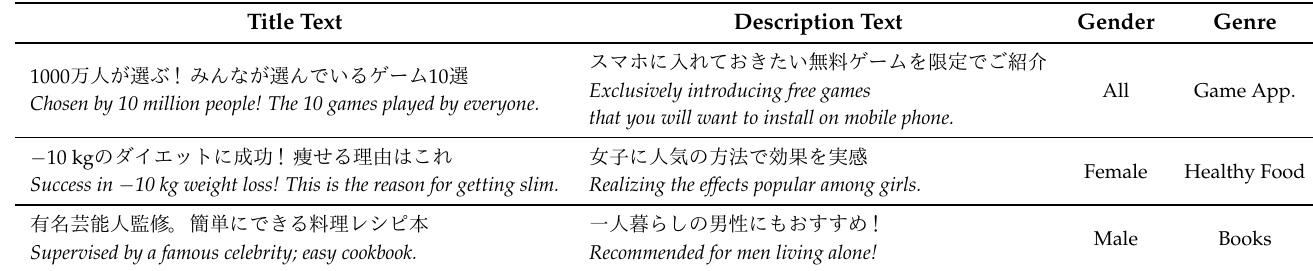
Table 2. Examples included in the ad creative dataset. In addition to the Japanese title text and description text shown here, the dataset contains categorical information (e.g., gender of the serving target, genre of the ad creative), images (e.g., the image attached to the ad creative), and numerical information (e.g., the number of impressions, clicks, conversions, and the CPA for the ad